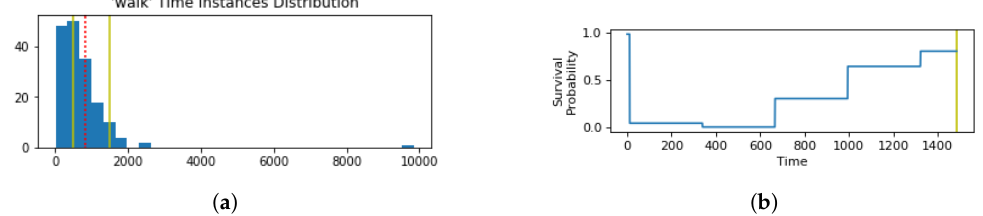
Figure 7. ( a ) Histogram of duration spent in a state found in the user historical record; ( b ) survival probability using the distribution function for the survival